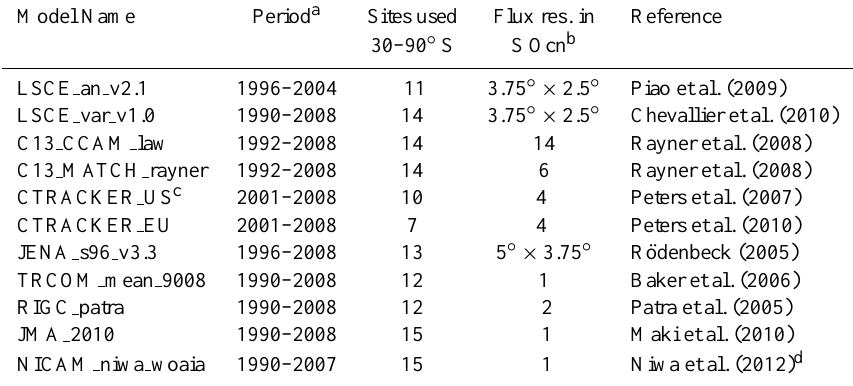
Table 2. Atmospheric inverse models and periods over which data was evaluated in this study, the number of sites south of 30 ◦ S, model resolution and the reference to each